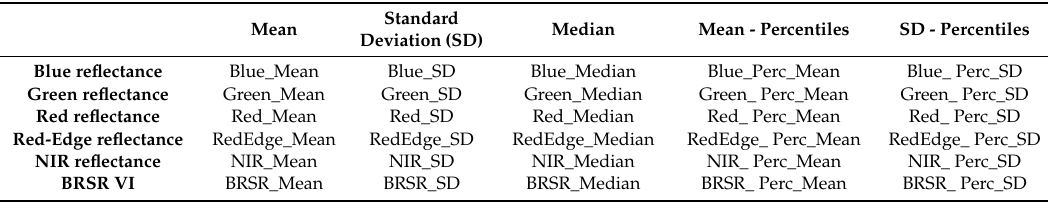
Table 5. List of the GEOBIA object features with their associated names used in the study.